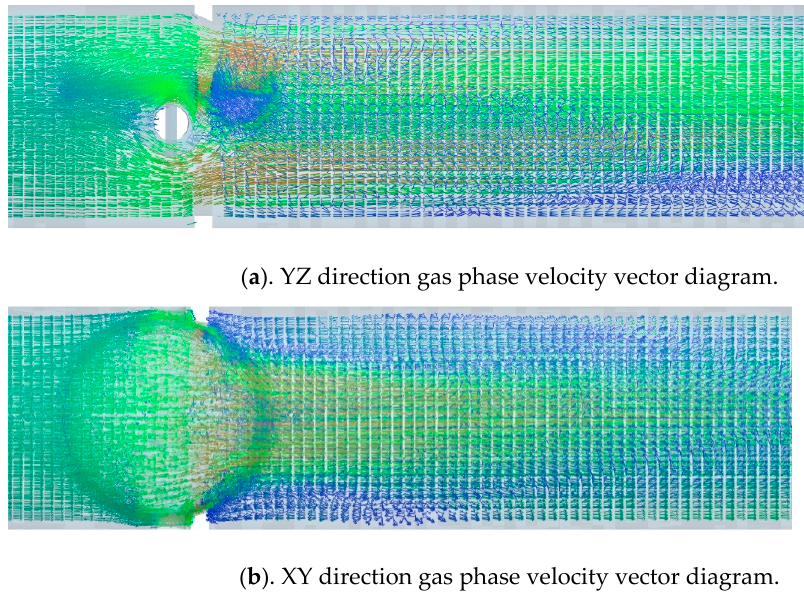
Figure 11. Flow field vector diagram where in the figure, the flow velocity in the red area is greater than that in the green